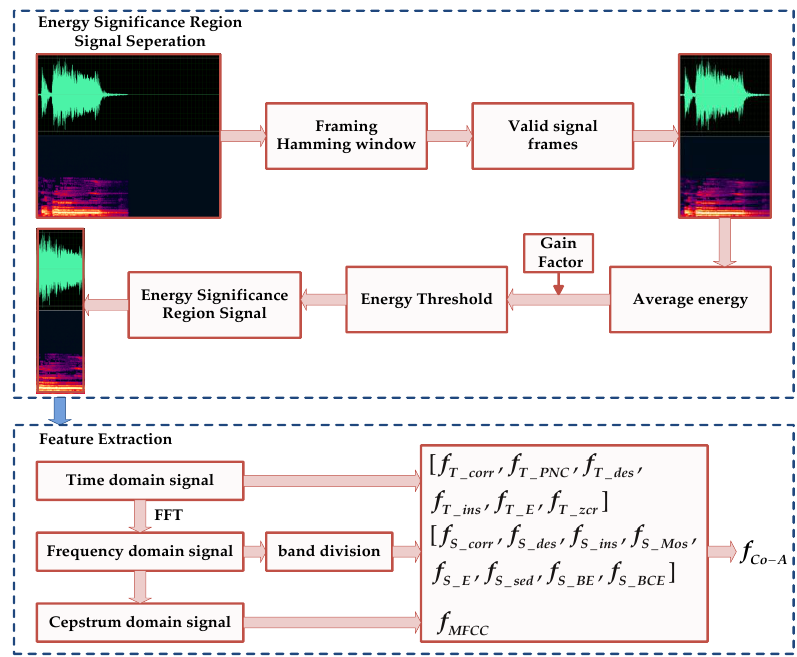
Figure 3. The RJSA feature extraction process.